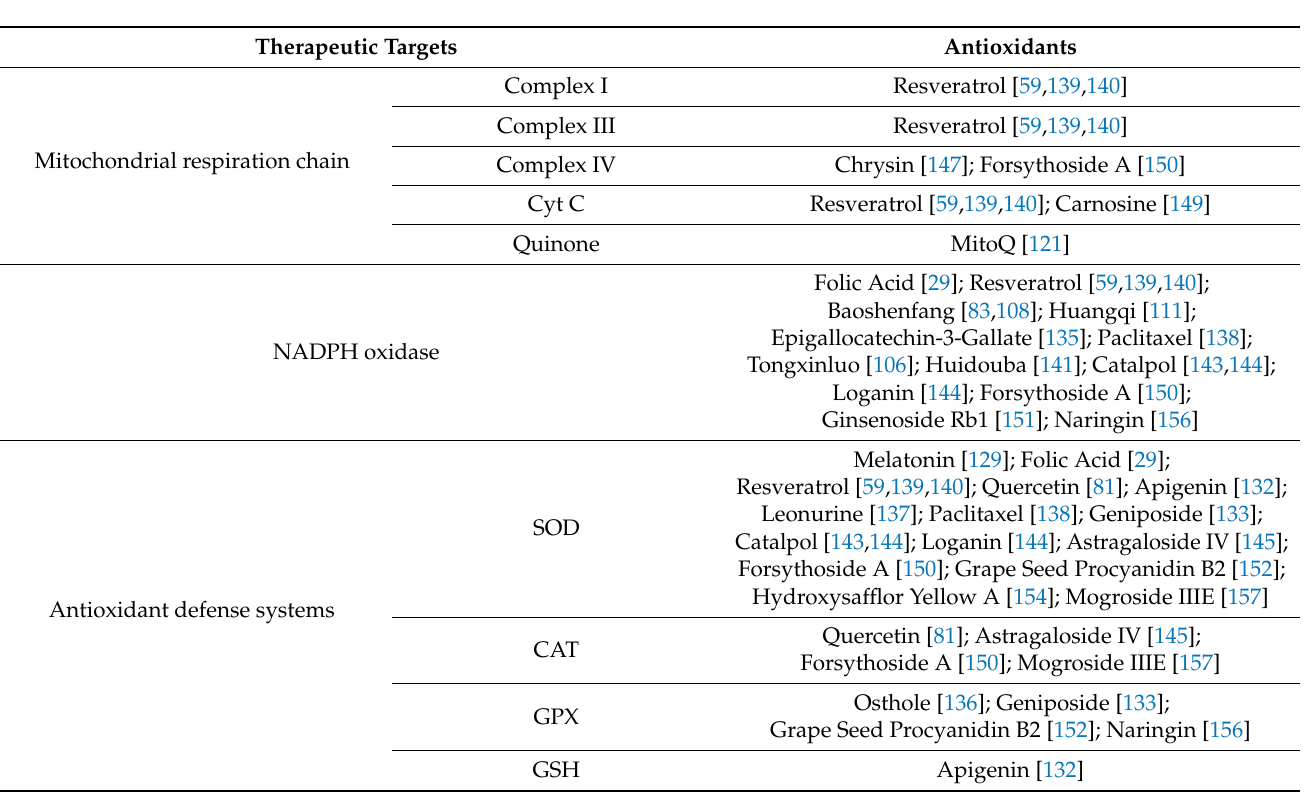
The therapeutic targets of the antioxidants described above are summarized in Table 2. Table 2. A summary of the therapeutic targets of antioxidants that can protect the podocyte from